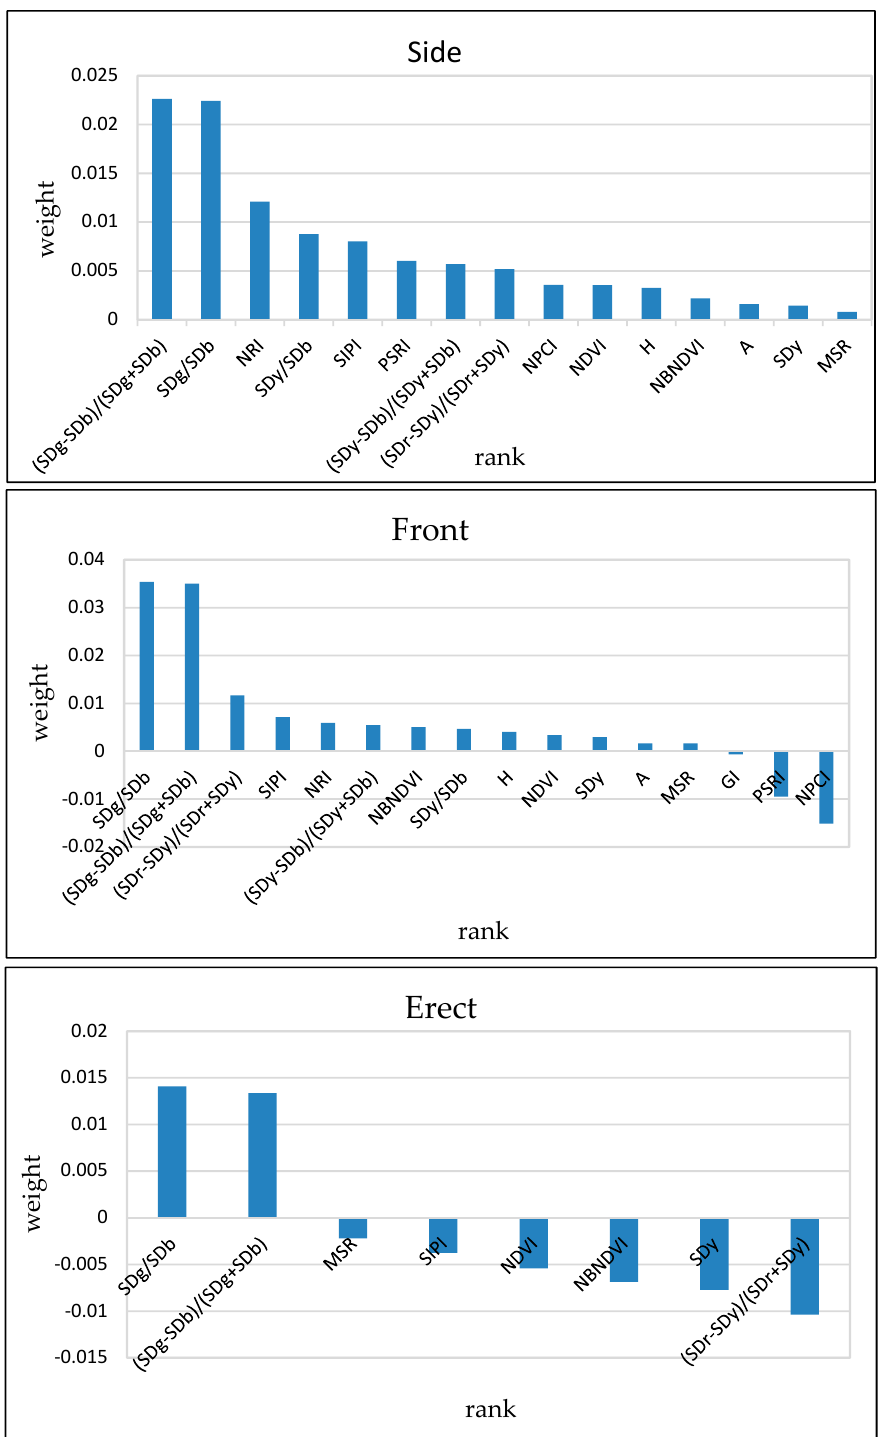
Figure 7. The important weights of selected features in the models at side, front, and erect